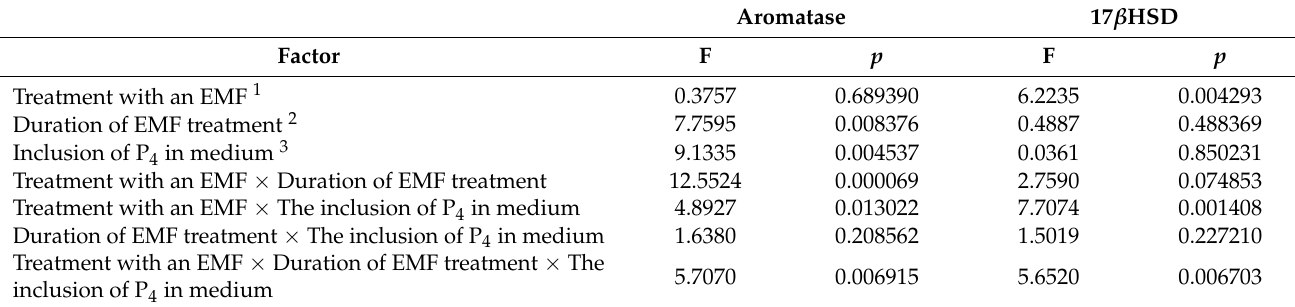
Table 2. The main factors and the interactions affecting the aromatase and 17 β HSD protein abundance in porcine my- ometrium collected from pigs during the peri-implantation period (days 15–16 of pregnancy) and treated in vitro with an EMF at 50 and 120 Hz for 2 and 4 h of incubation with or without the inclusion of P 4 (multi-way